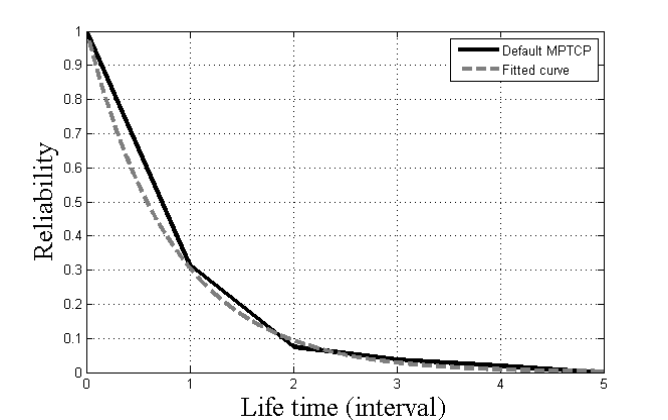
Figure 5. The reliability of the lifetime interval and its fitting